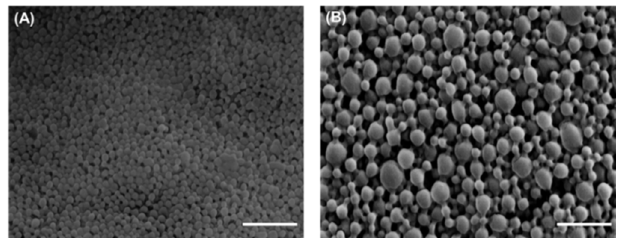
Figure 2. SEM images of ( A ) CafA-modified and ( B ) unmodified BAR-encapsulated PLGA NPs. Images are representative of a minimum of 3 independent samples, with n > 500 NPs assessed in total. Scale bars represent 1 µm.